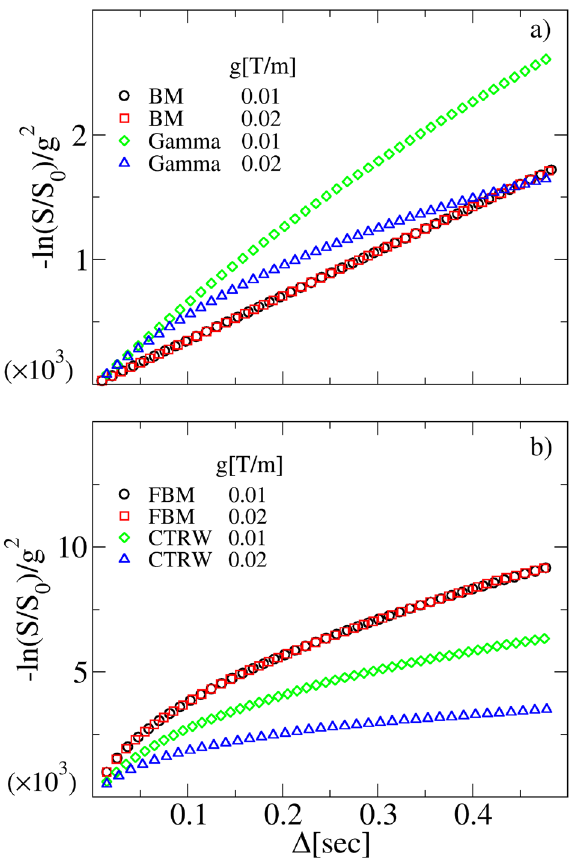
hypotheses (6) and (7). The continuous-time random-walk (CTRW) model 36,46,81 is a pure stochastic jump